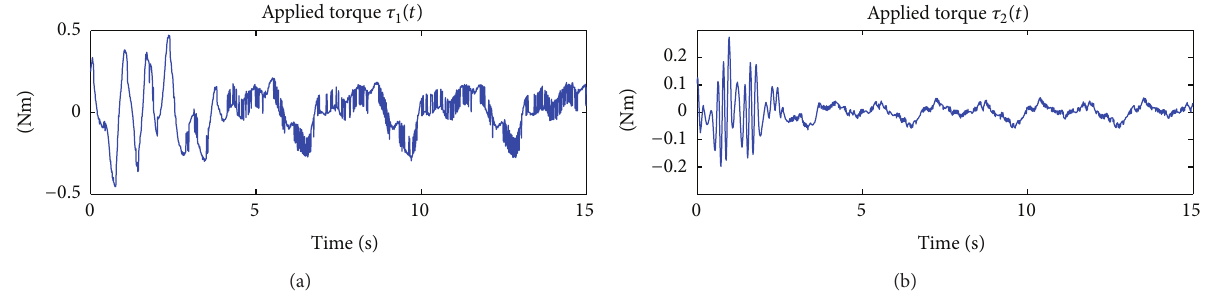
Figure 5: Applied torque by using the ANN + PD + Δ sign ( r ) scheme which considers adaptation.